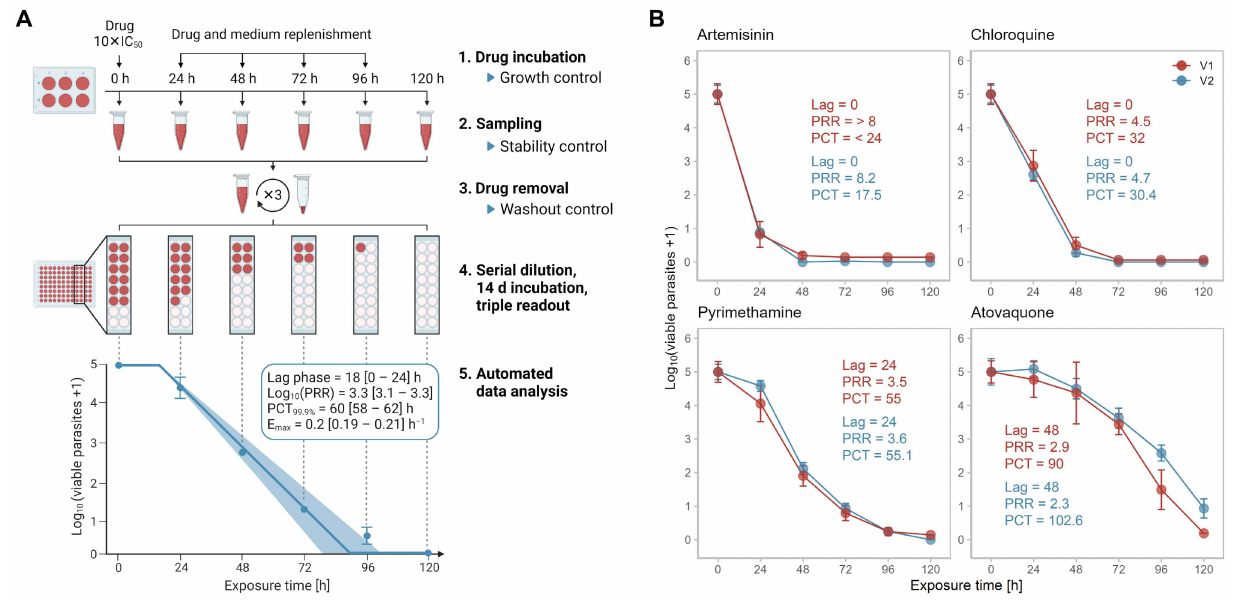
Figure 2. The in vitro PRR assay version 2 (V2). ( A ) Experimental setup. Cultures of P. falciparum strain NF54 are incubated with compound at 10 × IC 50 , which was predetermined following 72 h of drug incubation. Drug is replenished every 24 h. At 0, 24, 48, 72, 96, and 120 h, a culture aliquot is taken and washed three times. Drug-free parasites are serially diluted and incubated in 96-well plates for 14 days in order to allow the viable parasites to resume growth to a measurable culture. Finally, the number of viable parasites present after washing can be extrapolated from the number of dilutions still yielding parasite-positive wells. An automated data analysis calculates pharmacodynamics (PD) parameters from the normalized raw data. In parallel, drug stability and washing efficiency are monitored with two bioassay-based quality controls and untreated parasite cultures serve as growth control. ( B ) Validation of the new experimental protocol with a shorter assay duration based on the reference compounds artemisinin, chloroquine, pyrimethamine and atovaquone. Killing profiles and PD parameters were obtained using the original PRR assay (V1, red) [6] or the PRR assay V2 (V2, blue) with a shorter assay duration. Drugs were tested at 10 × IC 50 (or 100 nM for atovaquone in V2) in ≥ three independent experiments; error bars represent standard error of the mean (SEM)